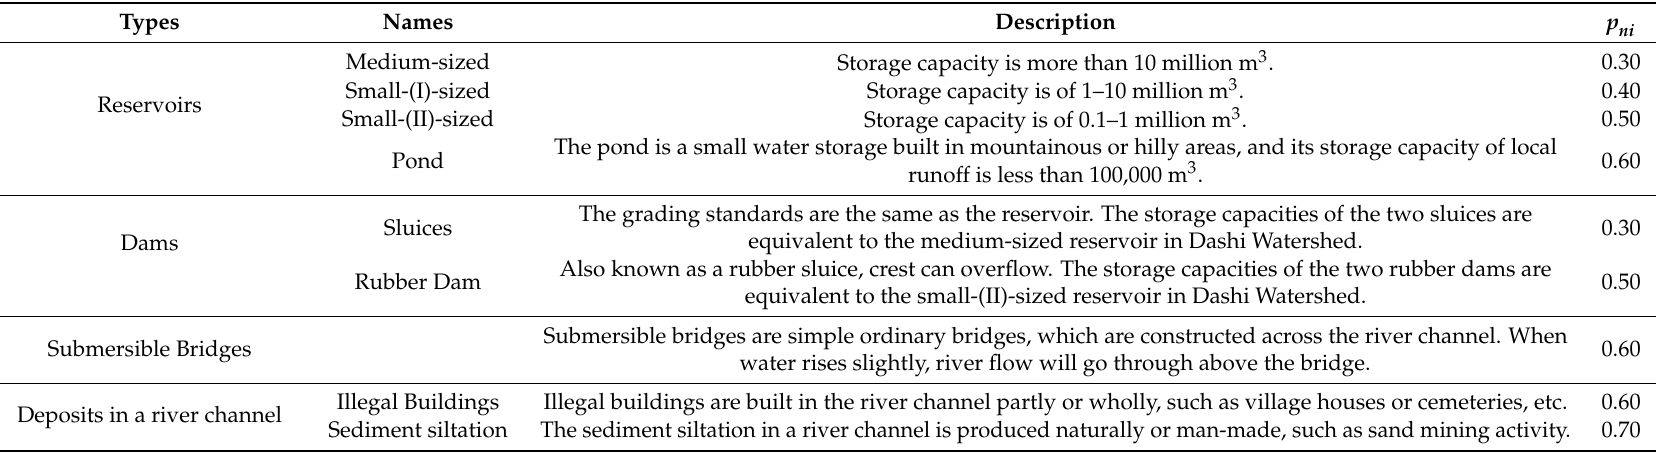
Table 1. Classification, grade, and blocking weight assignment of